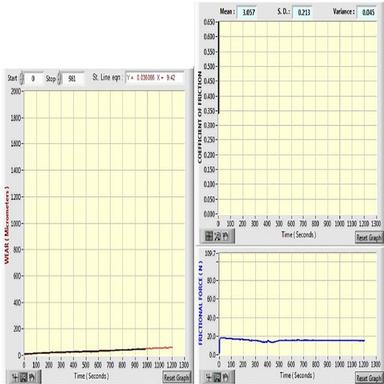
Variation of Wear rate, coefficient of force and frictional force of Al-SiC FGM with respect to time at 55 N, 473 rpm and 30 min wear time.